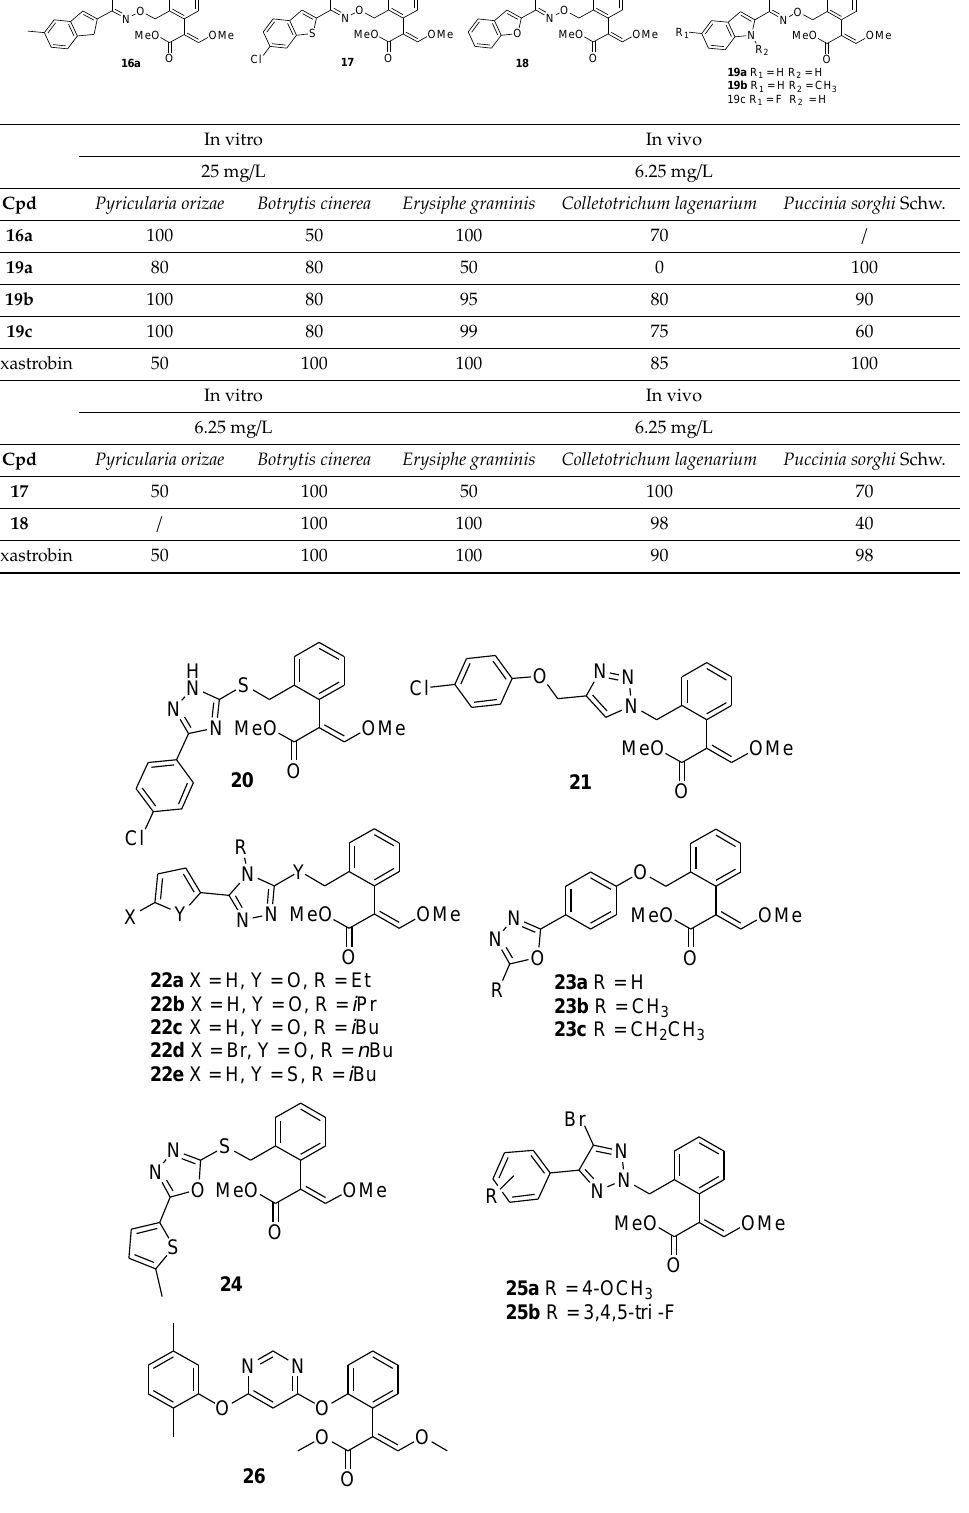
Figure 6. Structure of strobilurin derivatives containing a triazole moiety ( 20 – 25 ) and structure of azoxystrobin analog 26 .